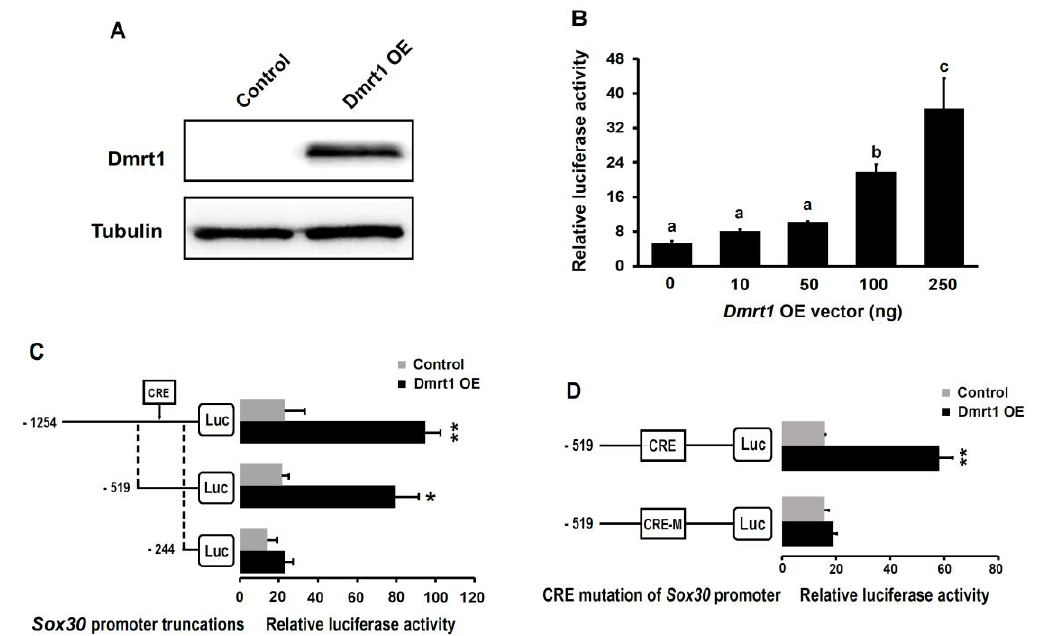
Figure 4. Effects of Dmrt1 overexpression on the activity of the Nile tilapia Sox30 promoter. ( A ) Western blotting validation of the overexpression of the Nile tilapia Dmrt1 gene in human HEK293 cells. Cell lysates and total proteins were prepared separately from the cells with and without Dmrt1 overexpression. Anti-Dmrt1 antibody and anti-Tubulin antibody were used. ( B ) Dosage-dependent effects of Dmrt1 overexpression on the luciferase expression driven by the Sox30 promoter in human HEK293 cells. Different dosage of pcDNA3.1- Dmrt1 overexpressing vectors were separately co-transfected into HEK293 cells with a construct containing a luciferase reporter driven by the Nile tilapia Sox30 promoter. An empty construct without Dmrt1 was used as the control. Luciferase reporter analysis indicates that Dmrt1 overexpression promoted the activities of the Nile tilapia Sox30 promoter in a dosage-dependent manner. ( C ) Effects of Dmrt1 overexpression on the luciferase expression driven by several 5′ -truncated regions of the Sox30 promoter in HEK293 cells. ( D ) Effects of Dmrt1 overexpression on the activity of the Nile tilapia Sox30 promoter with a mutation of putative CRE for Dmrt1. The data represent the means + SE ( n = 3). Different letters above the error bars in ( B ) and ( C ) indicate statistical differences at p < 0.05, as determined by one-way ANOVA followed by the post hoc test in ( B ). *, p < 0.05; and **, p < 0.01 compared with the control in ( C ) and ( D ). OE, overexpression. Luc, luciferase; M, mutation.